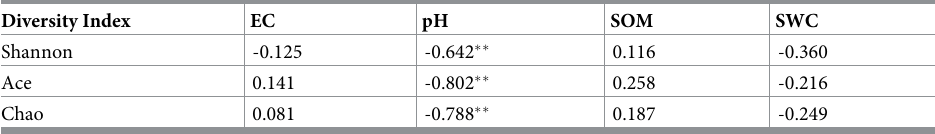
Table 3. The correlation coefficients between soil properties and the diversity index.